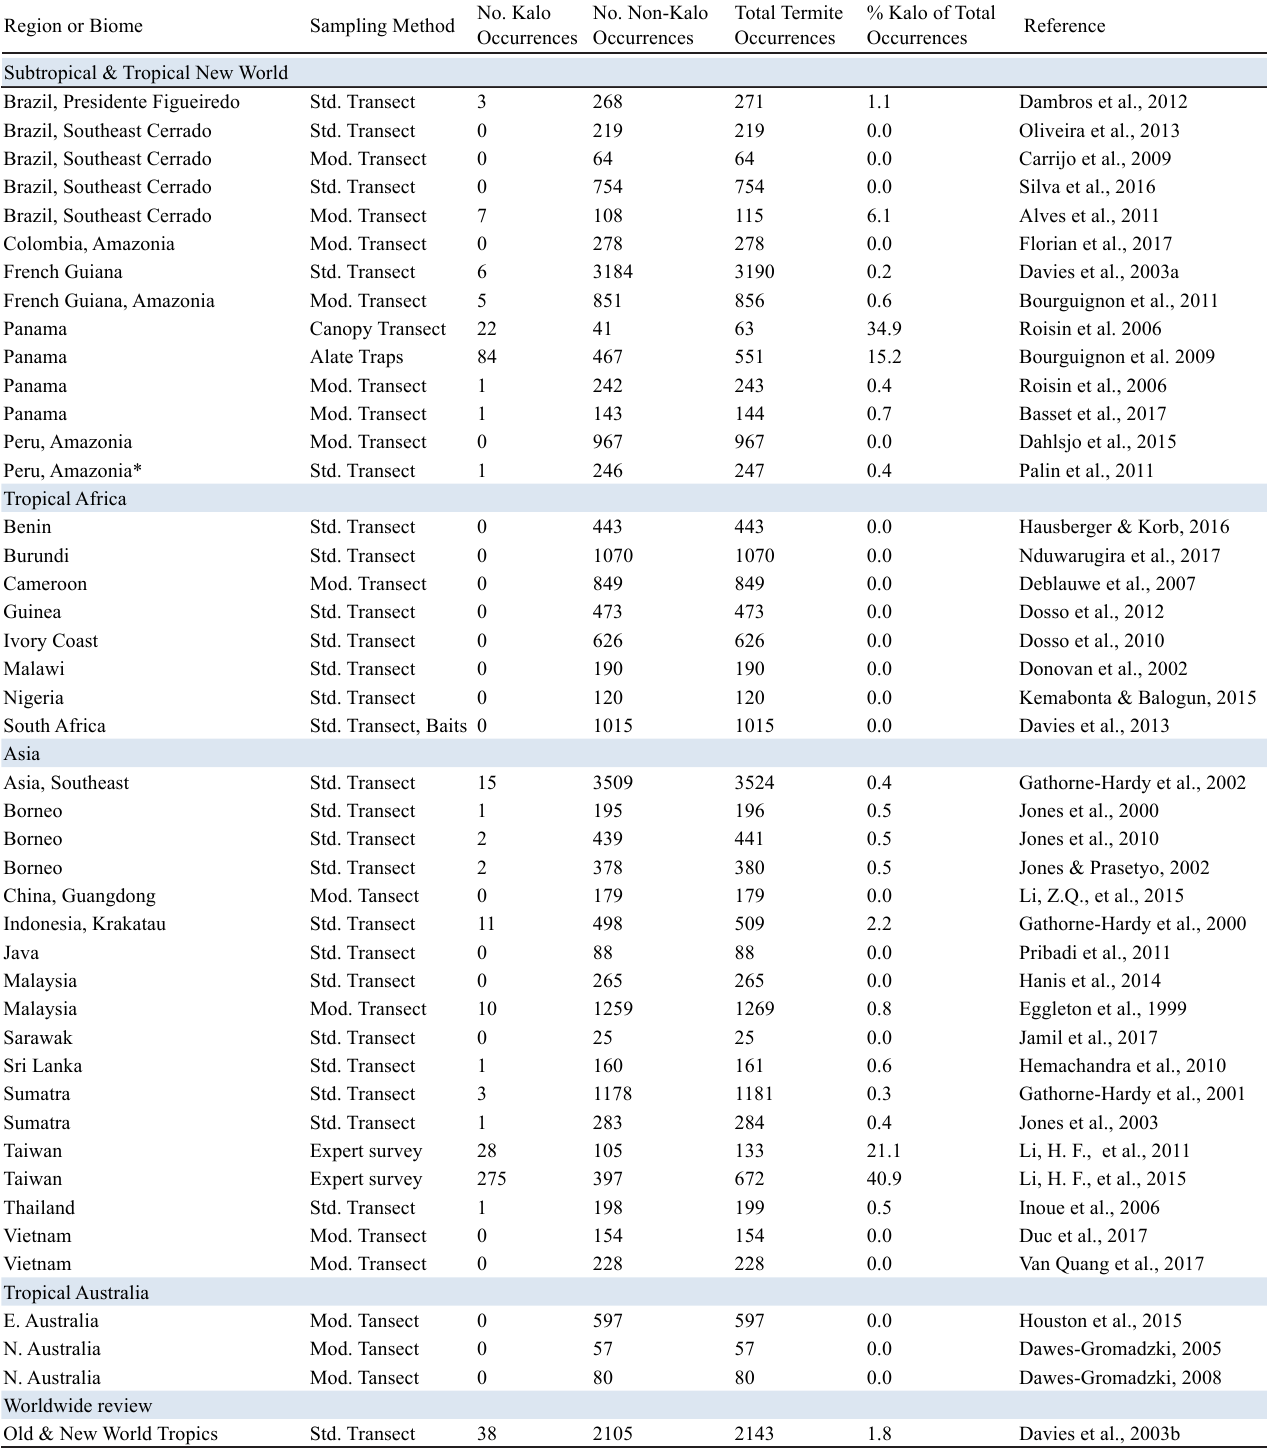
Table 1 . Studies listing occurrences of kalotermitid and non-kalotermitid termites in wooded habitats by sampling method. (Continuation) Region or